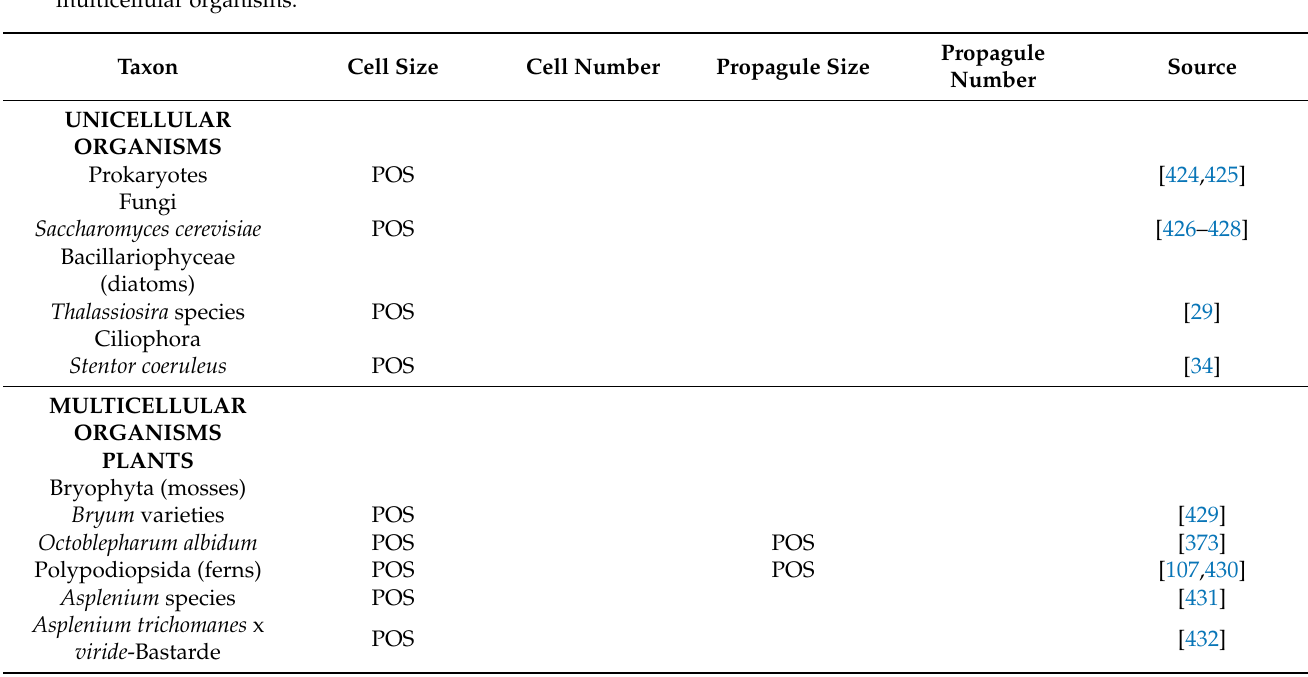
Table A2. Effects of polyploidy on cell or propagule (or gamete) size and number in various taxa of unicellular and multicellular